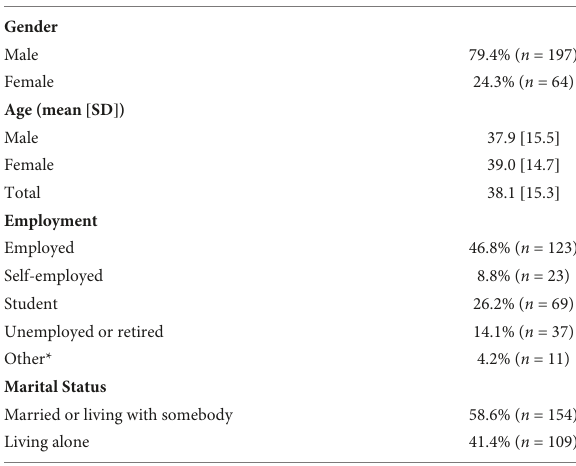
TABLE 1 Socio-demographic description of the